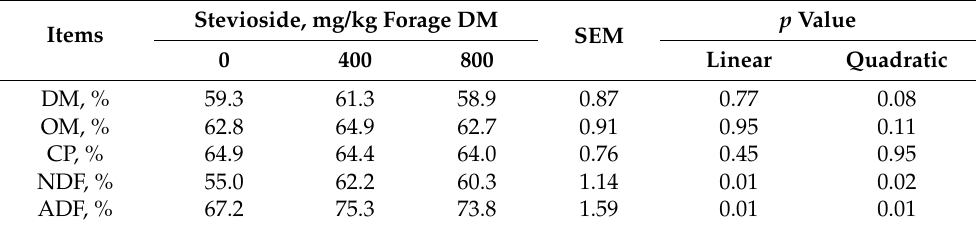
Table 4. Effects of stevioside on apparent total tract digestibility in goats *.